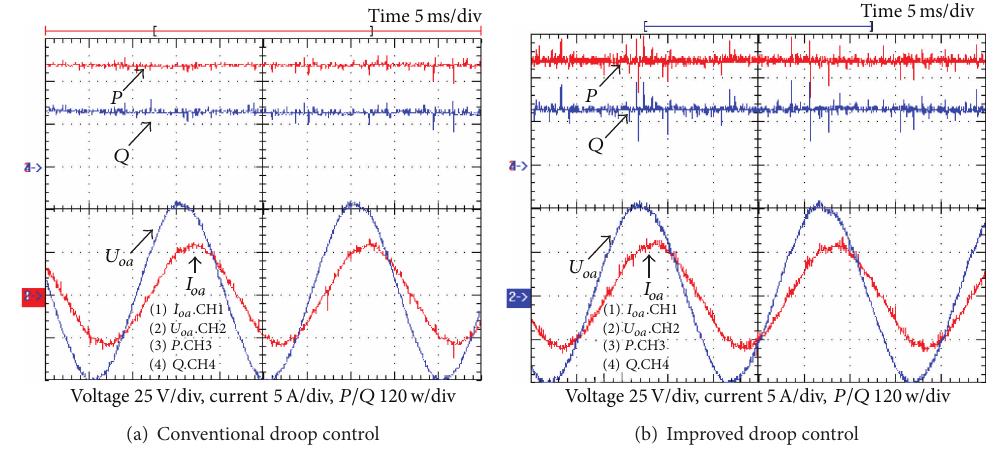
Figure 9: Experimental results of steady-state